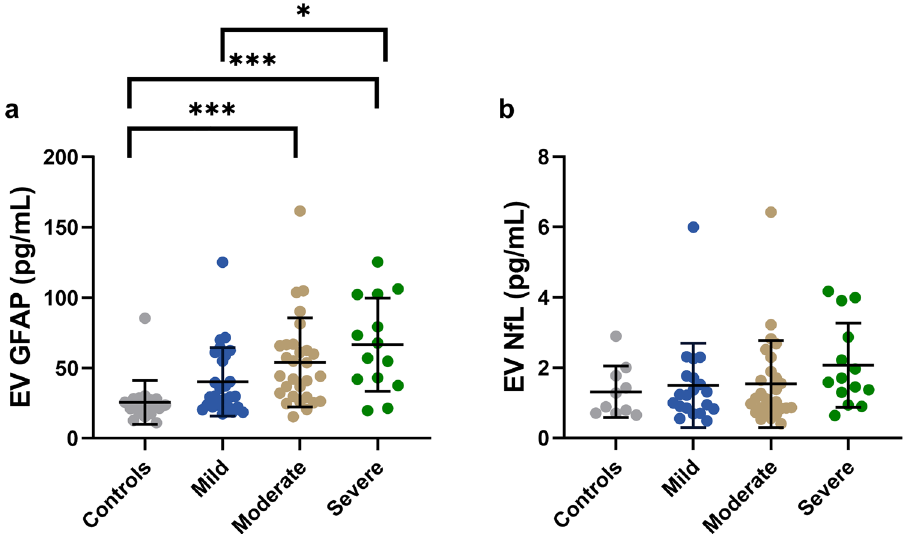
Figure 1. Biomarker differences in TBI patients compared to controls and across TBI severity. ( a ) EV GFAP was elevated in modTBI and sTBI compared to controls as well as in sTBI versus mTBI (n = 89). ( b ) EV NfL showed no significant alterations across TBI severity groups or between TBI severity groups and controls (n = 71). Error bars represent SD, with the middle bar indicating the mean. *p < 0.05, ***p < 0.001, adjusted